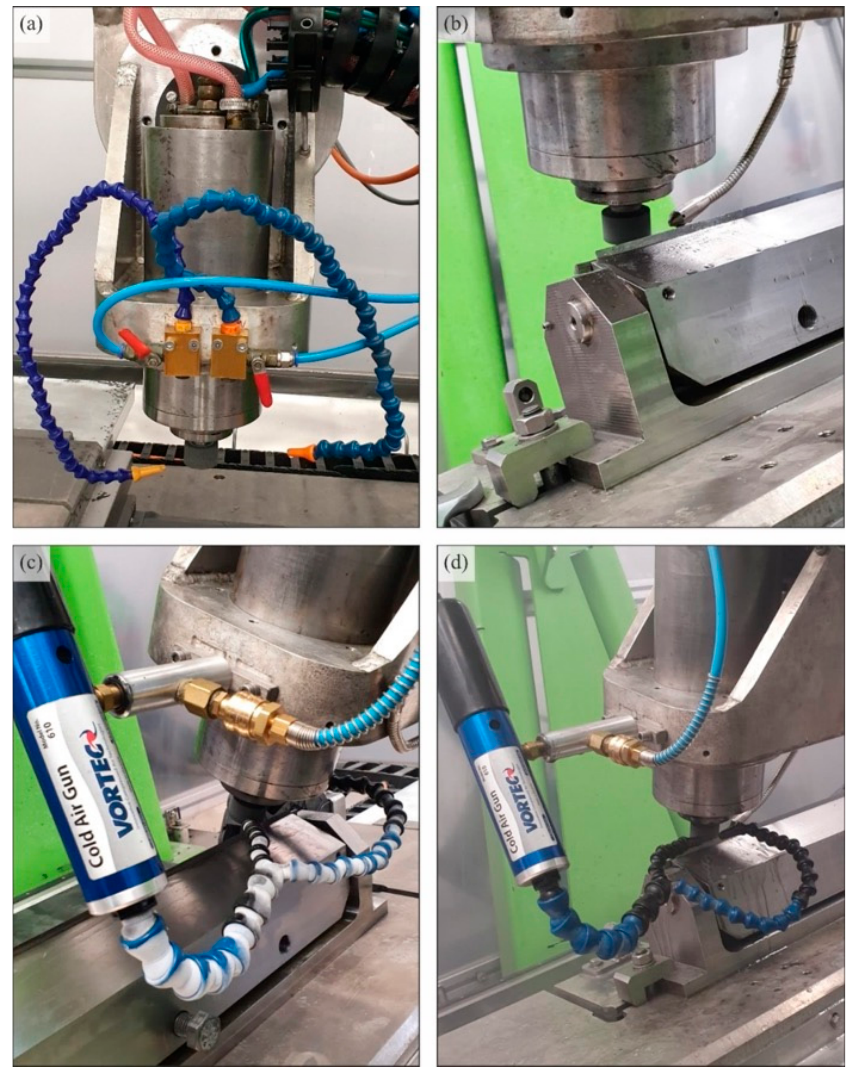
Figure 2. View of the grinding zone in a configuration that allows the use of ( a ) flooding method (WET); ( b ) minimum quantity lubrication (MQL); ( c ) cooling with cooled compressed air (CAG); ( d ) hybrid method involving the simultaneous use of MQL and CAG nozzle (MQL + CAG). Table 1. Designation and main technical parameters of the grinding wheel [42].